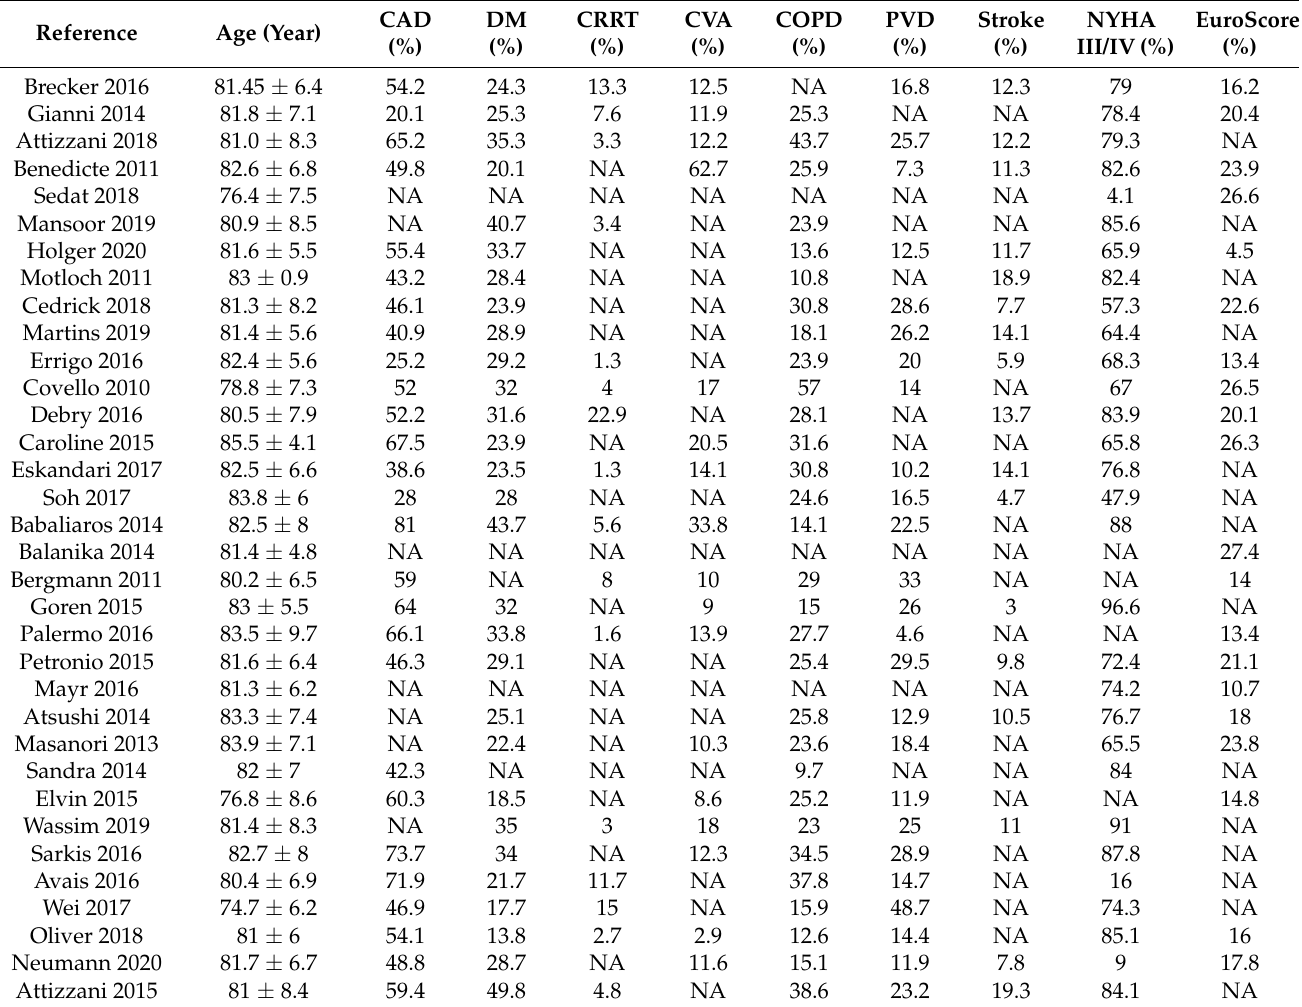
Table 2. Baseline characteristics, medical conditions, and perioperative data of included studies for